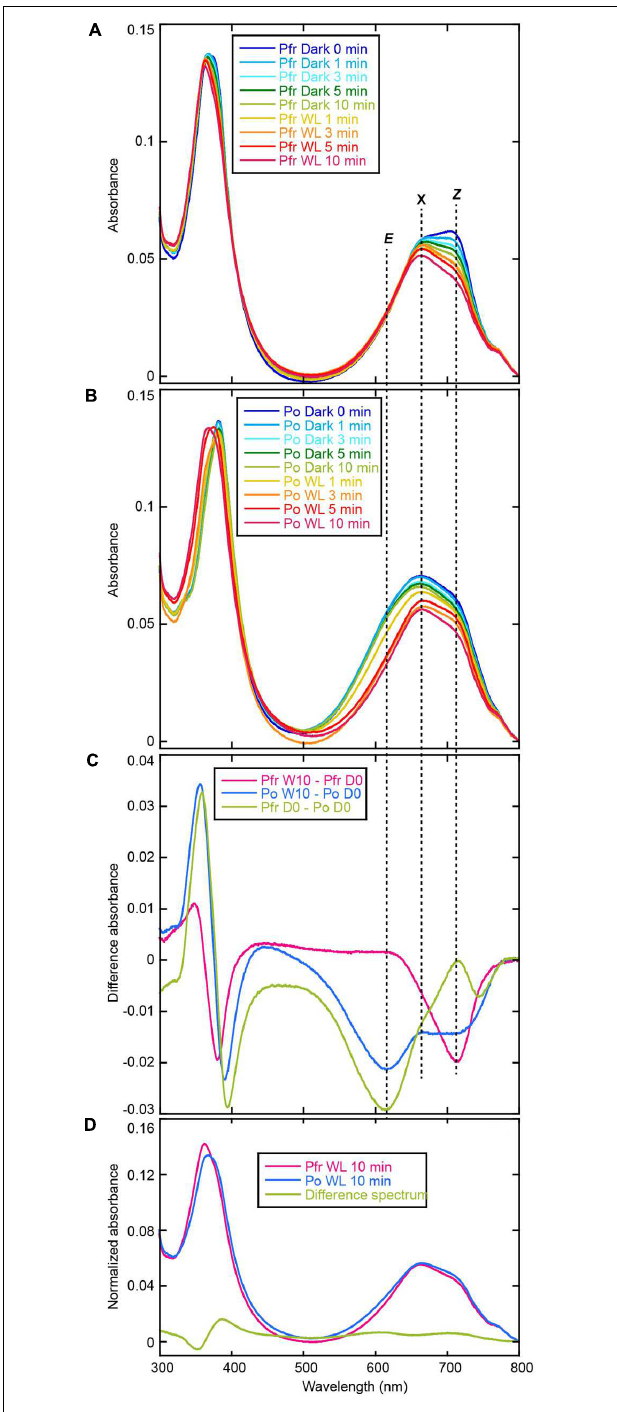
FIGURE 6 | Acid denaturation of AM1_C0023g2-BV. (A) Absorption spectra of acid-denatured AM1_C0023g2-BV Pfr during dark and light processes. (B) Absorption spectra of acid-denatured AM1_C0023g2-BV Po during dark and light processes. (C) Difference spectrum during dark and light processes of denatured Pfr (magenta), during dark and light processes of denatured Po, and of Pfr-minus-Po just after denaturation (green). (D) Normalized absorption spectra and difference spectrum of acid-denatured AM1_C0023g2-BV Pfr and Po after dark and light